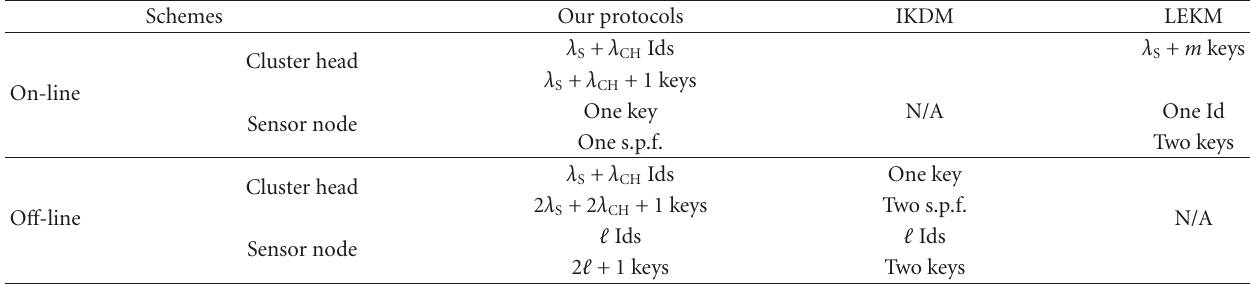
Figure 5: Protocol illustration of adding a new cluster head when BS is o ff -line. Table 2: Storage cost comparison over various distribution